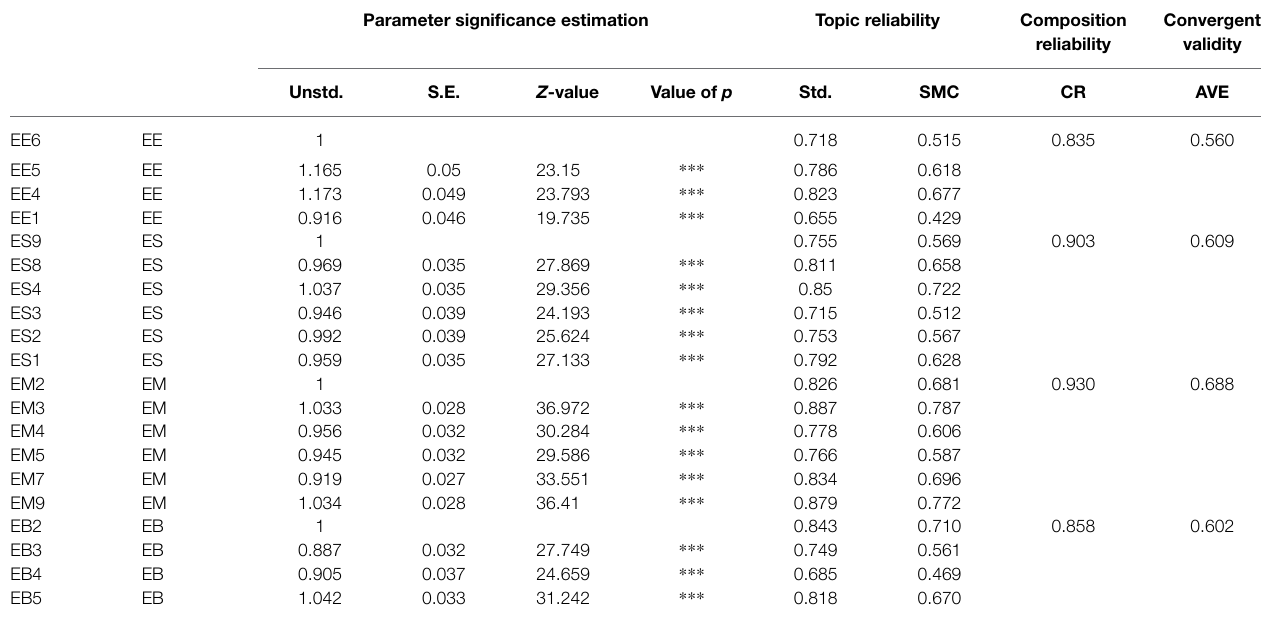
TABLE 4 | Confirmatory factor analysis.